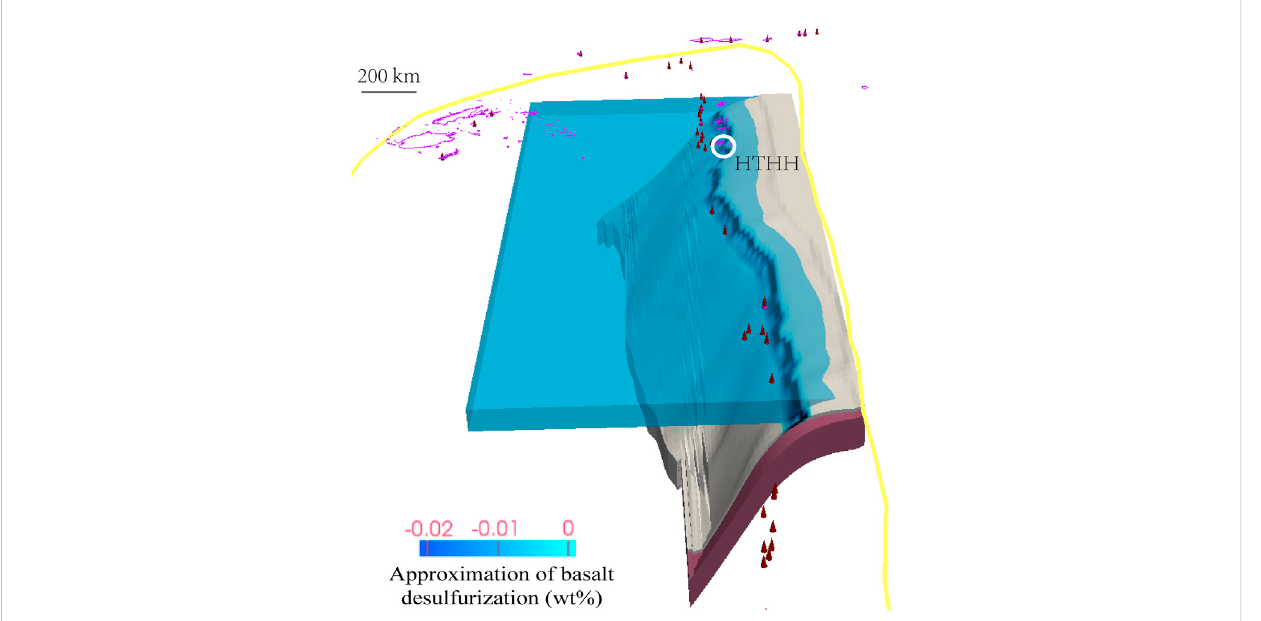
FIGURE 6 Three-dimensional distribution of desulfurization of the basalt layer in the subducted Paci fi c Plate below the HTHH volcano. The red cones denote thevolcanoes.Thebluestripeonthesubductedplaterepresents thedesulfurizationbeltontheplateinterface.Themid-oceanridgeisshownonthetop of